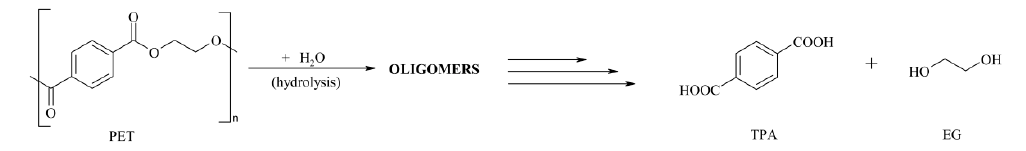
Figure 5. Neutral hydrolysis of PET [40].